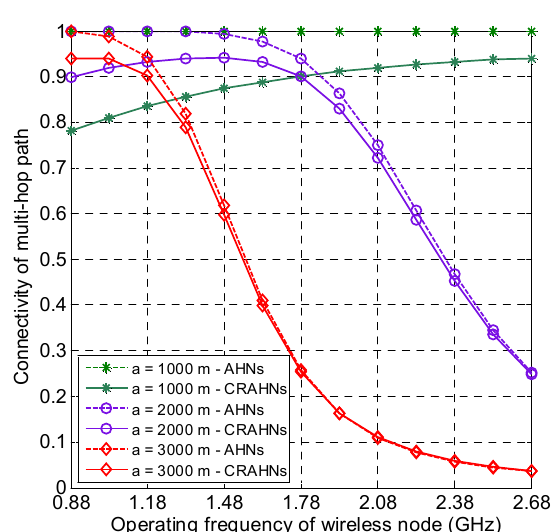
Figure 10 . The connectivity of multi-hop path in CRAHNs with different network sizes; number of PUs = 3, number of SUs = 100, average active rate of PU = 0.1, one frequency layer with operating frequency = 0.88 GHz ~ 2.68 GHz.